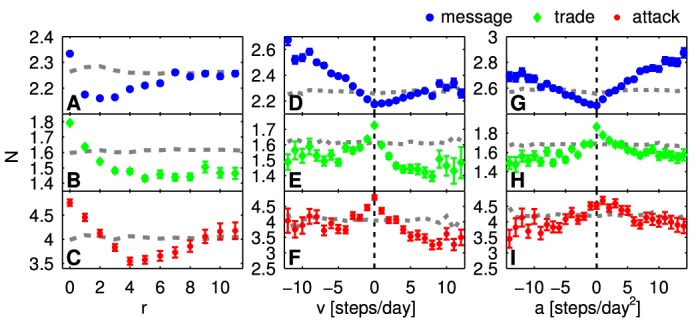
Average number of (uni-directional) interactions per day as a function of r
β, v
β, and a
β.Errorbars are standard deviations of the mean. The results for randomized data are shown with dashed gray lines. Clearly, interaction intensity is strongest for players in the same sector (r = 0). For trade and attack, stationary players (with velocity and acceleration zero) interact the most. For messages, interaction is most intense for players who move towards each other but slow down.